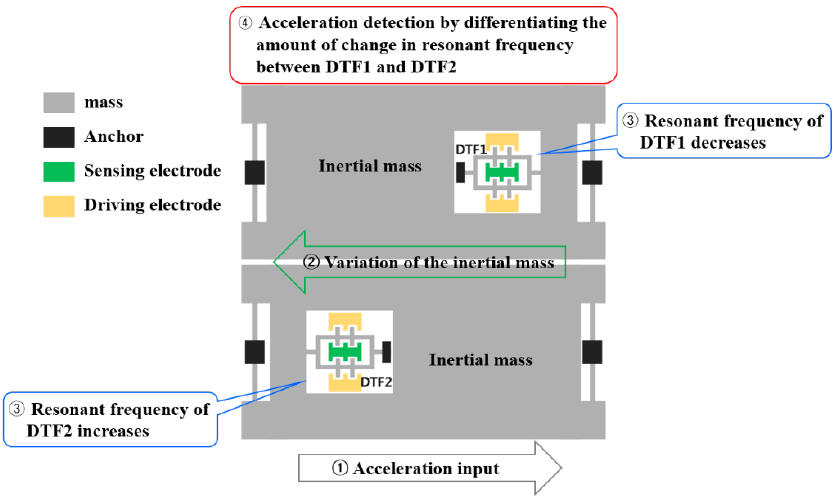
Figure 3. Conceptual diagram of the principle of detecting acceleration.